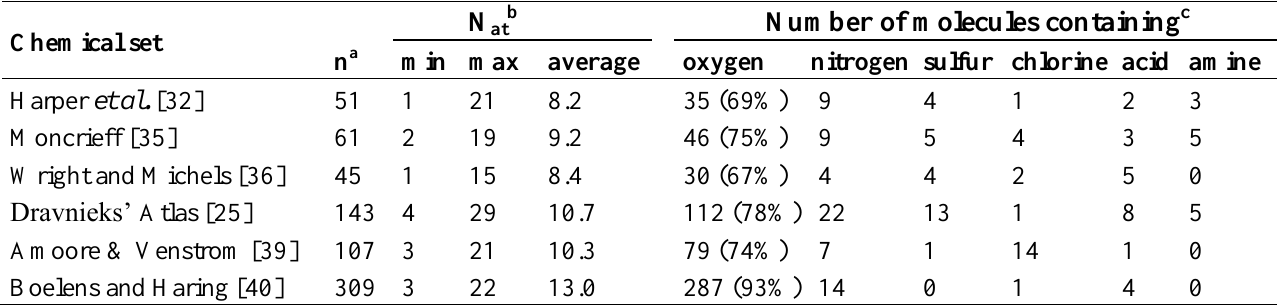
Table 1. Basic description of the chemical sets according to the empirical formula of the compounds. N atb Number of molecules containing c Chemical set n a min max average oxygen nitrogen sulfur chlorine acid amine Harper et al. [32] 51 21 Moncrieff [35] Wright and Michels [36] Dravnieks’ Atlas [25] 143 29 10.7 Amoore & Venstrom [39] 107 Boelens and Haring [40]